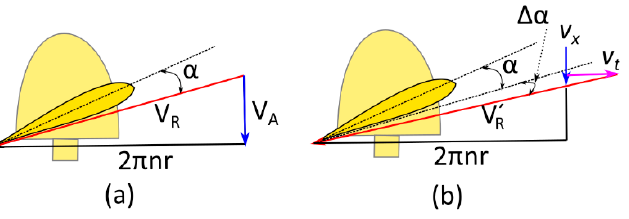
Figure 5. Change of inflow angle at the propeller blade section on account of the induced ESD velocity. Case ( a ) velocities and angle of attack on propeller section without ESD; Case ( b ) velocities and angle of attack on propeller with ESD (Pre-Swirl device).